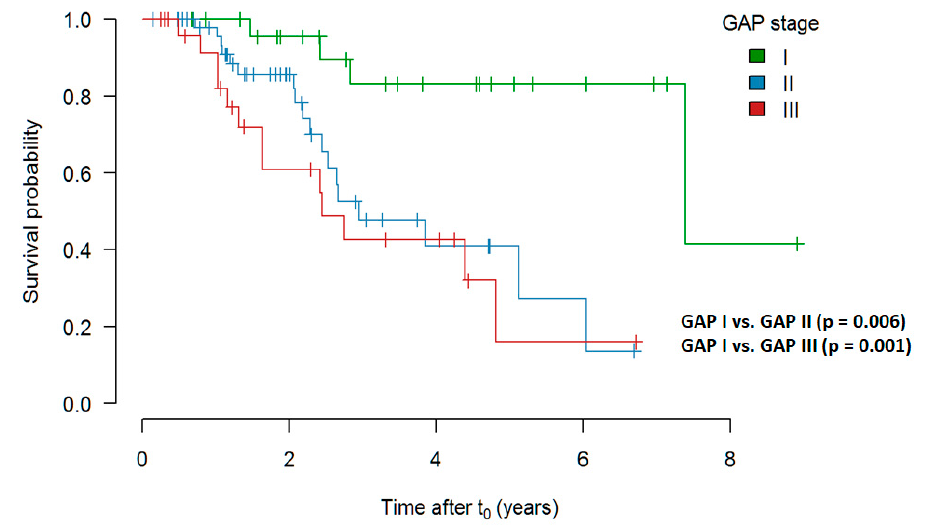
Abbreviations: GAP—Gender, Age, Physiology.